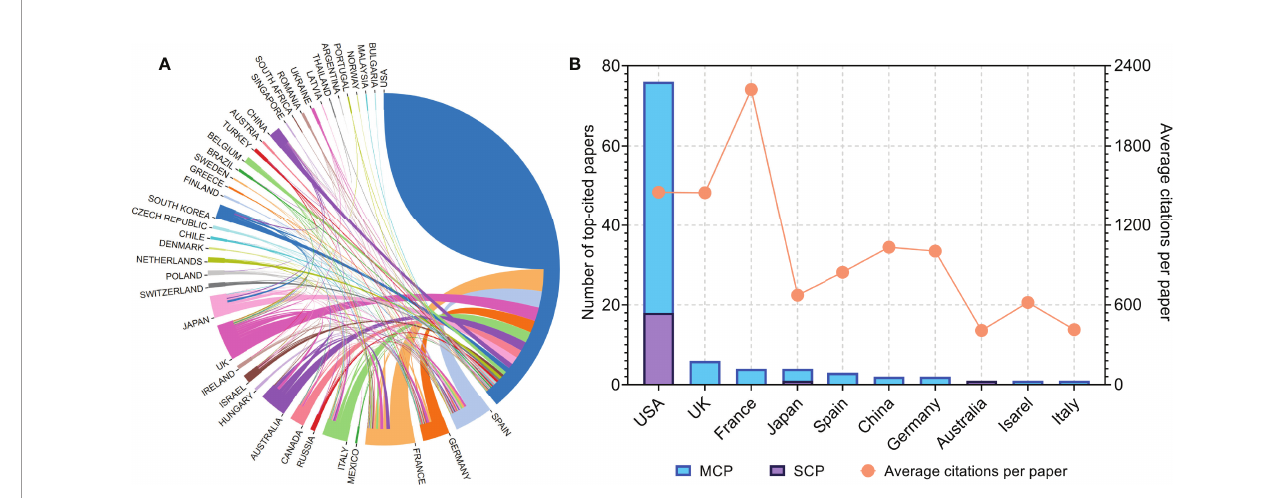
FIGURE 2 | (A) Network visualization map of inter-country/-regional collaboration. (B) Total number of top-cited papers and average citations per paper according to the countries of corresponding authors. MCP, multiple-country publications; SCP, single-country